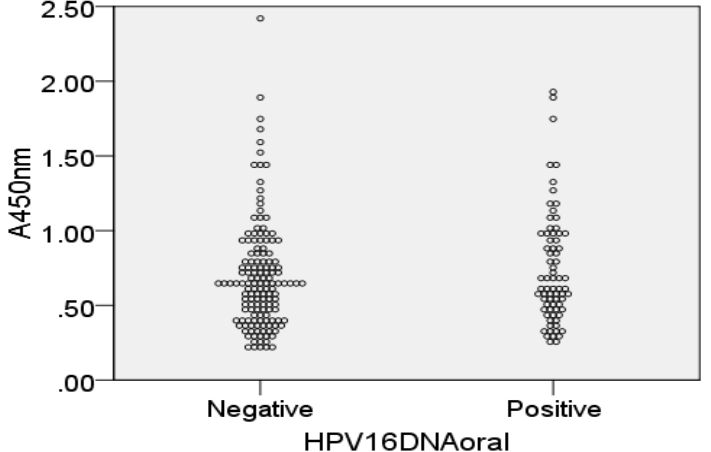
Figure 1. Dynamics of saliva and serum HPV16 L1 antibodies of women who had either persistent (blue lines) or transient (yellow lines) oral HPV16 infection. Mean: solid line, 95% confidence, up- per and lower: dashed line. ( A ) saliva sIgA, ( B ) saliva IgG, ( C ) serum IgA, and ( D ) serum IgG.